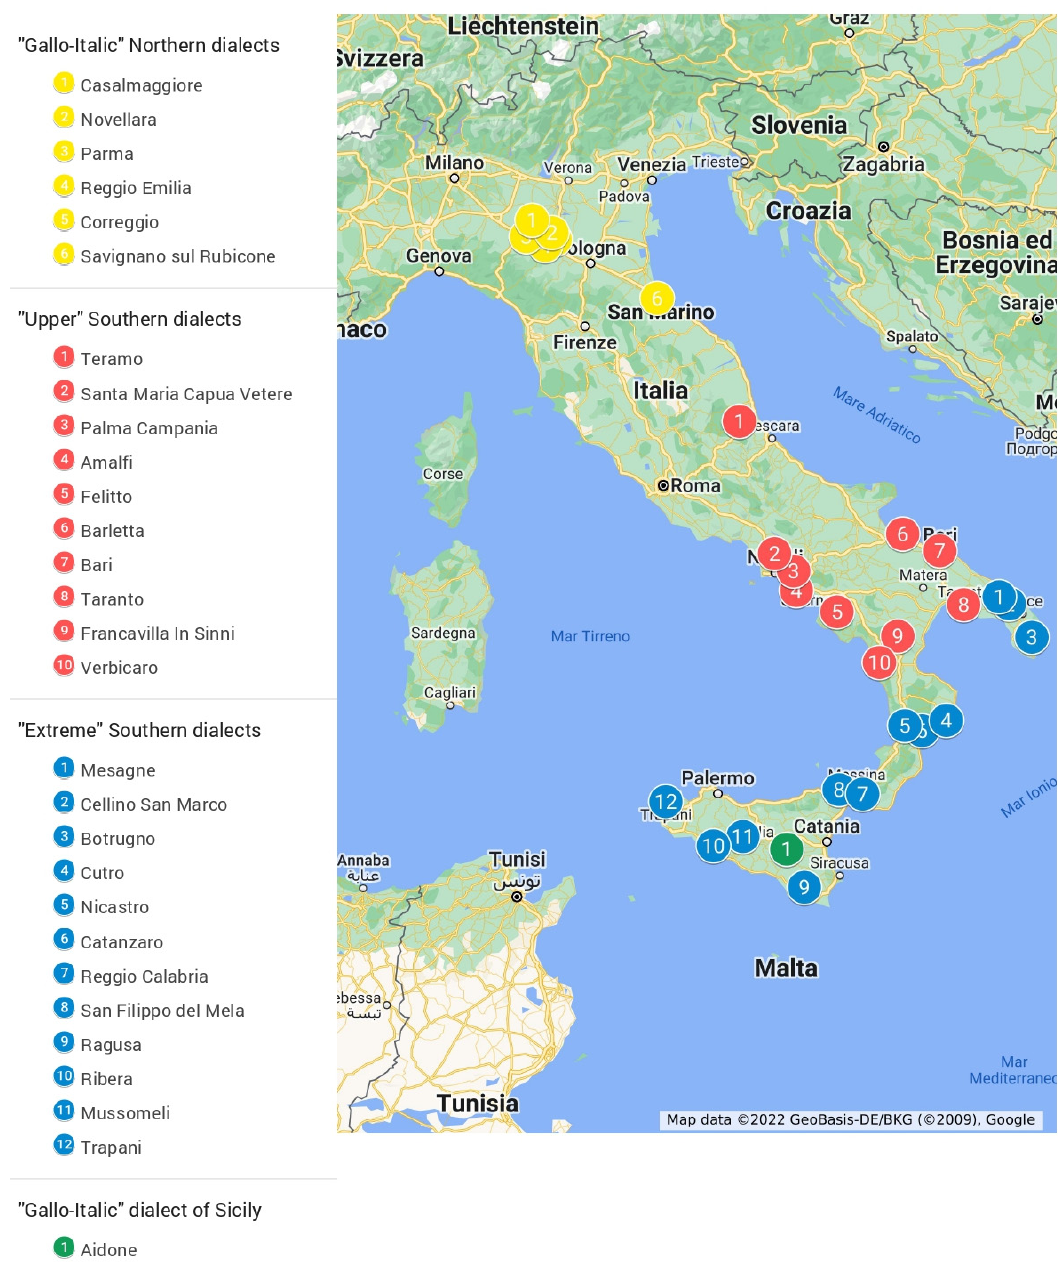
Figure A1. The dialects investigated.